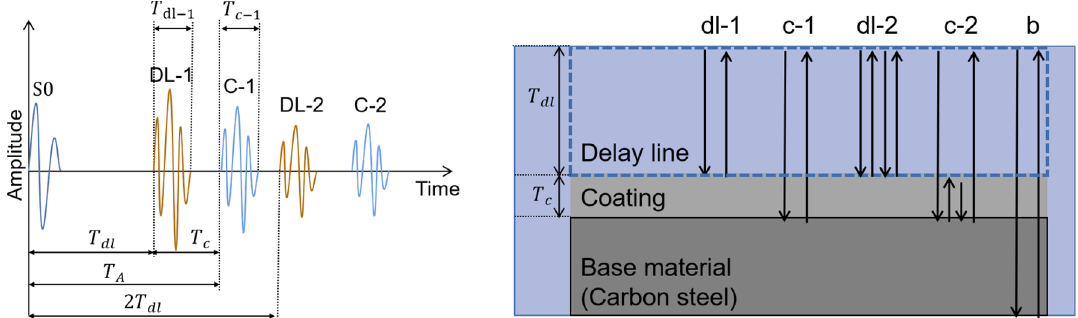
Figure 1. Schematic diagram using delay